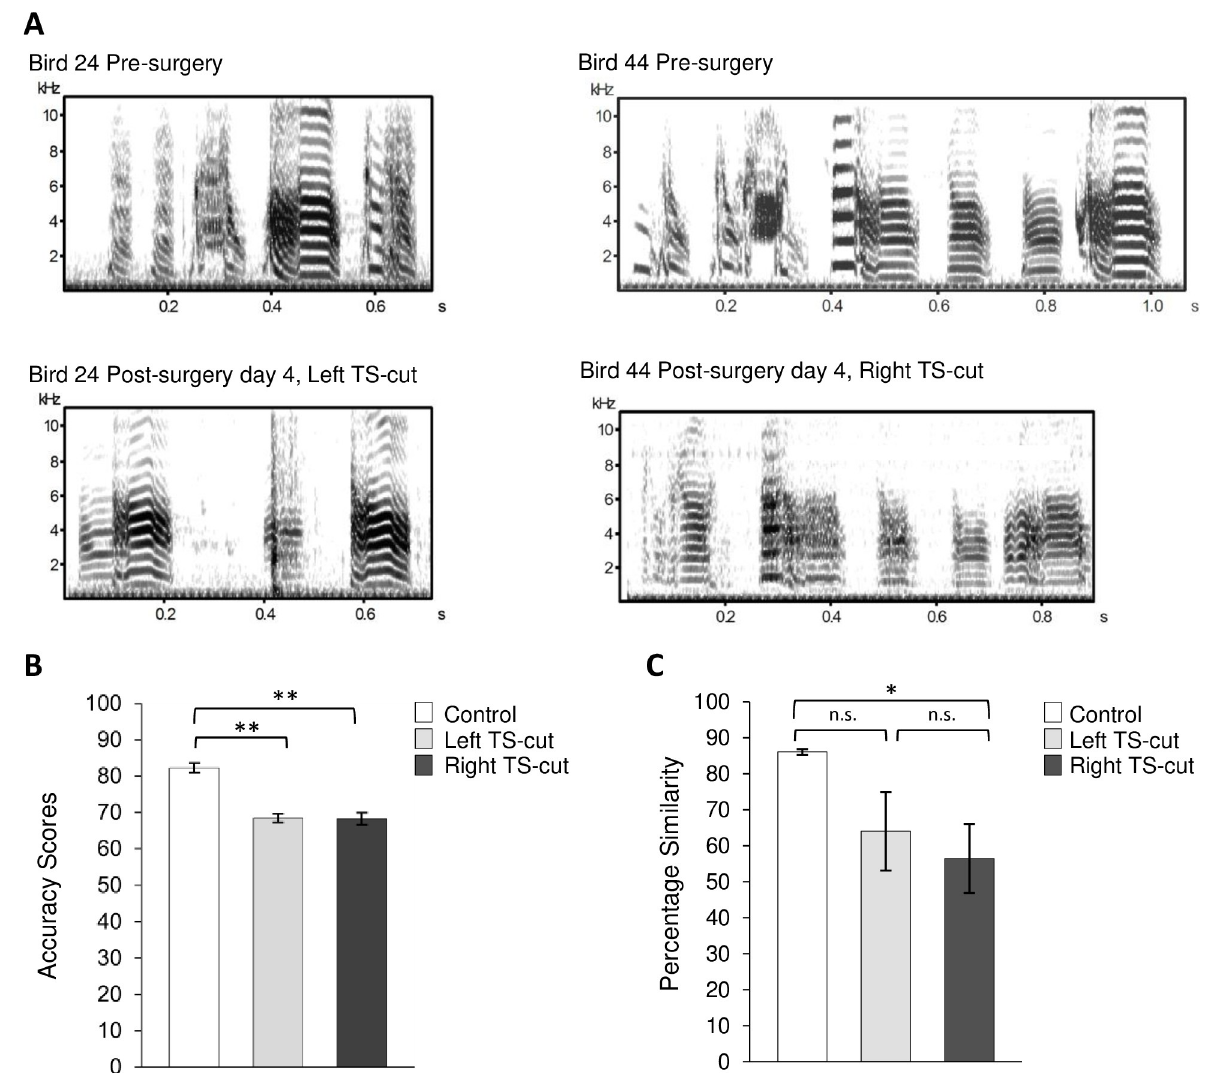
Fig 3. Effects of TS-cuts on song structure. A. Pre-operative spectrograms (top row) and post-operative spectrograms of left TS-cut (left) and right TS-cut (right) showing song changes after unilateral TS-cuts, recorded 4 days post-surgery. Changes in acoustic structure were highly varied across individuals. Spectrograms were generated with Sound Analysis Pro 2011 [56]. B. Birds that underwent left (n = 5) or right (n = 4) TS-cut had accuracy scores that were significantly lower than those of controls (n = 5), demonstrating that unilateral tracheosyringeal nerve cut impacted the quality of song production. C. There was a significant overall difference in the pre- to post- similarity scores among groups, and right TS-cut birds differed from controls. Control (n = 5), left TS-cut (n = 5), and right TS-cut birds (n = 4). Shown are means ± standard errors, � = p < 0.05, �� = p < 0.01, n.s. = p >